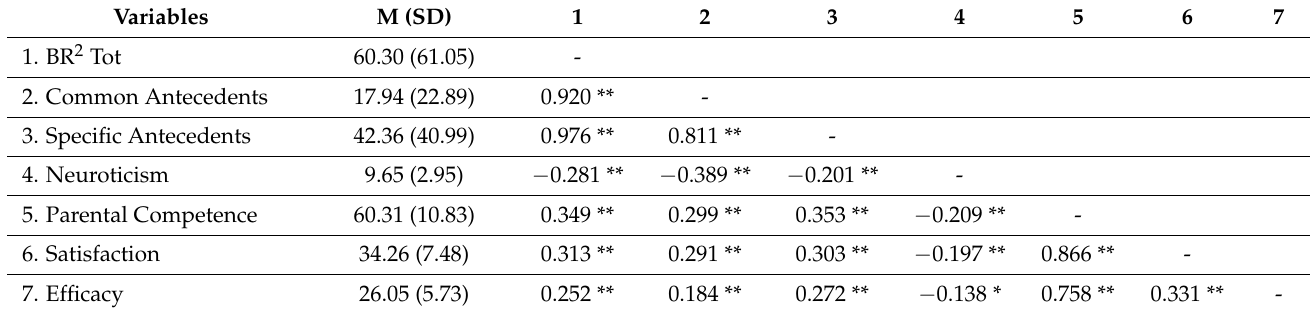
Table 3. Correlation between BR2, neuroticism personality factor, and parental competence variables.